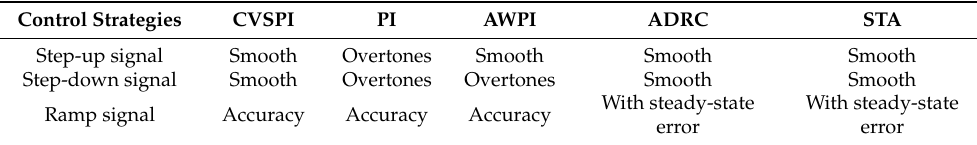
Table 7. Comparison of step and ramp signal performance.